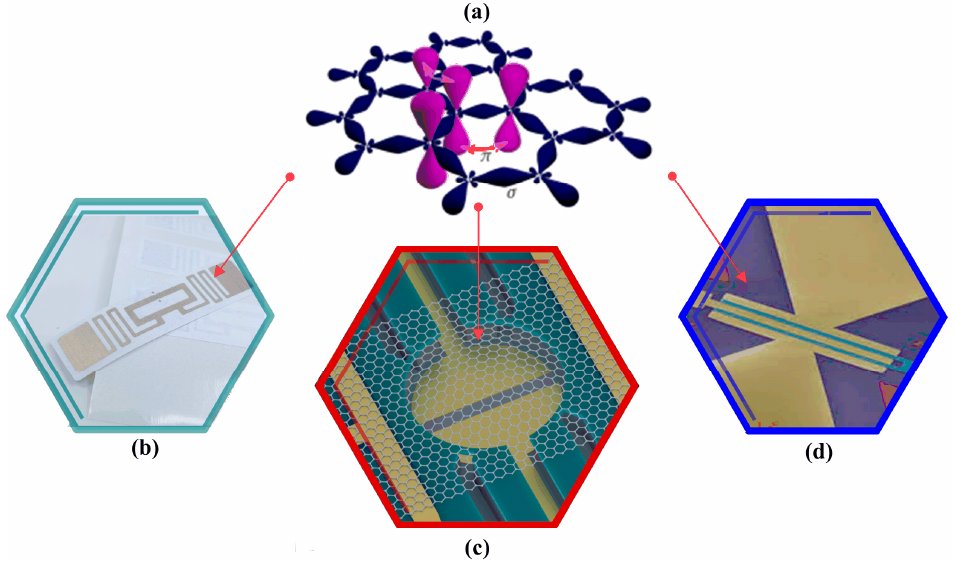
Figure 1. Graphene-based radio-frequency (RF) nanodevices and circuits. ( a ) Graphene: a single atomic sheet of sp2-bonded carbon [7]; ( b ) graphene-based radio-frequency identification (RFID) tag antenna [8]; ( c ) graphene-based frequency mixer; and ( d ) graphene-based 100 GHz transistor [9].